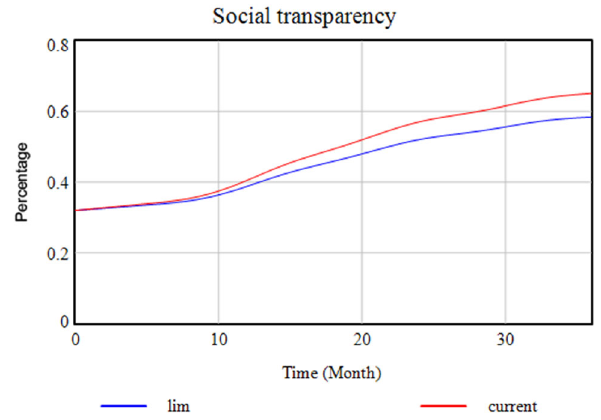
Fig. 11 Model behavior when the cost of the social program is at the boundary